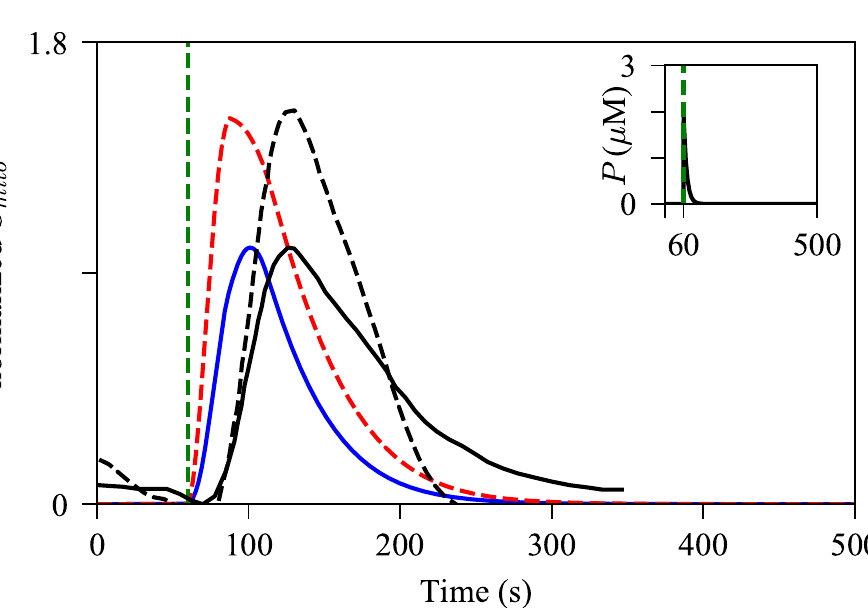
Fig 2. Effects of increased MAMs on amplitude of mitochondrial Ca 2+ activities. The model was simulated with a pulse of IP 3 , Eq 55 with M = 10, t 0 = 60, and Δ = 0.2, shown by the inset graph. The blue solid trajectory was simulated with ( R S1 , R S2 ) = (0.15, 0.15), while the red dashed spike was generated with the increased MAM surface ratios, ( R S1 , R S2 ) = (0.48, 0.48). The black solid curve represents experimentally traced mitochondrial Ca 2+ dynamics in control Hepa 1-6 cells, while the black dashed line describes that in the cells expressed with synthetic linkers. The green dashed line indicates the onset of the pulse in the model, and the time at which the cells were treated with 100 μ M of ATP in the experiment. The experimental traces were obtained from Arruda et al. [9].